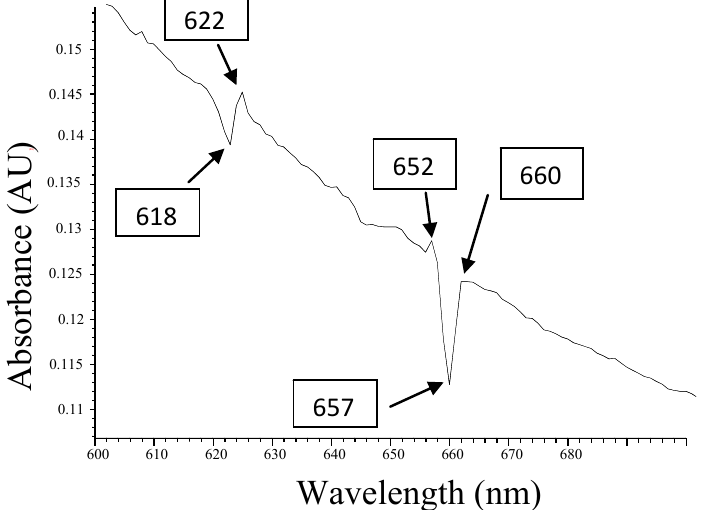
Figure 3. Absorbance analysis of UV-visible spectrum, which shows two small valley areas that illustrate the absorption changes centered at 618 nm and 657 nm, thus corresponding to the phaeophytins, Q